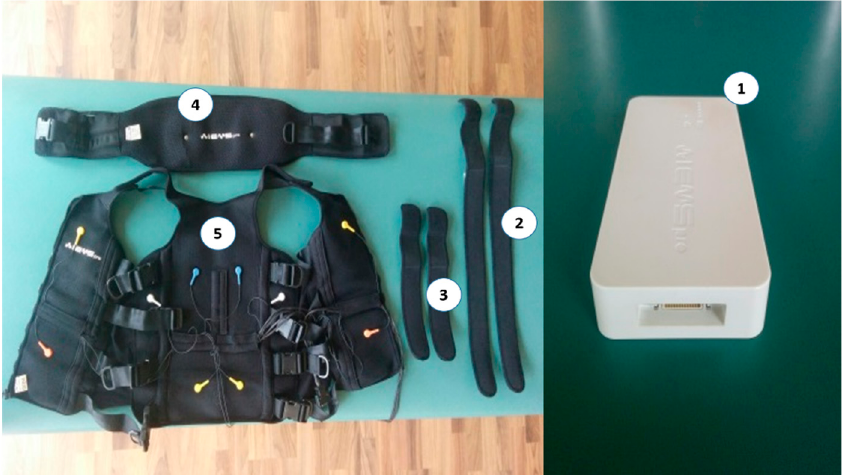
Figure 3. Wiemspro equipment. 1) The electromyostimulator device, 2) Strap electrodes for the thighs, 3) Strap electrodes for the arms, 4) Belt with electrodes for the buttocks, 5) Vest with electrodes for the abdomen, chest, and back area.